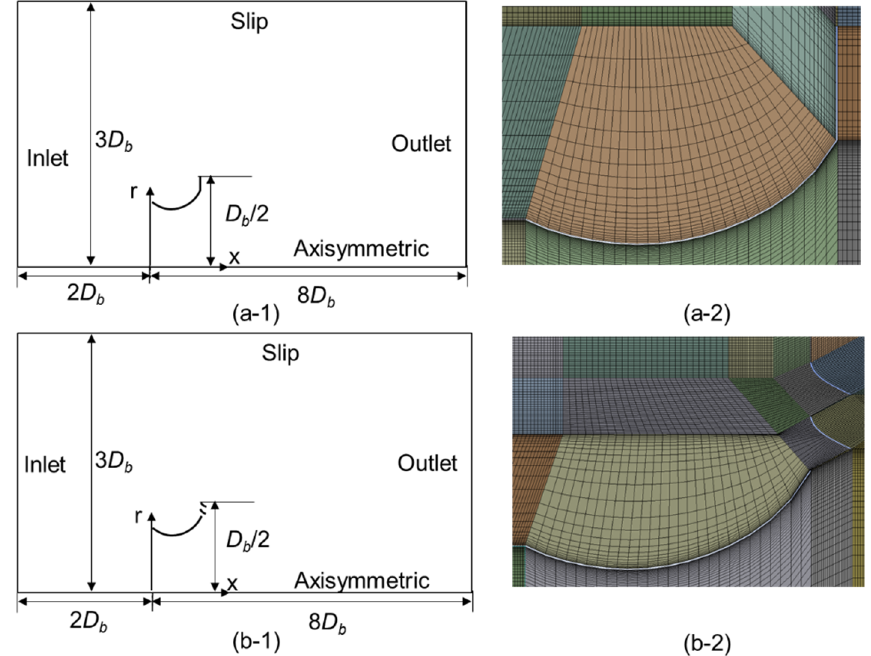
Figure 8. Computational domains, boundary conditions and grids: ( a-1 ) diffuser with a rigid and flat flange; ( a-2 ) related grids around the flanged diffuser; ( b-1 ) diffuser with a typical deformed self-adaptive flange; ( b-2 ) related grids around the flanged